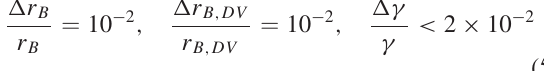
distributions for different electron energies (for a = − 0 . 103). The red lines are fits to the 1 / t (cid:7) 2 p · t 2 / m 2 ) and with electric field and corrections ( p 2 p p p